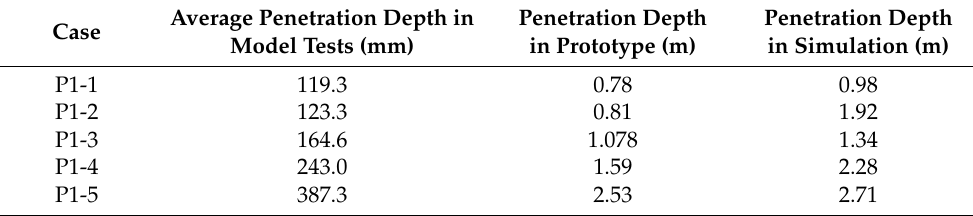
Table 14. Comparison of the penetration depth in the model test and numerical simulation.